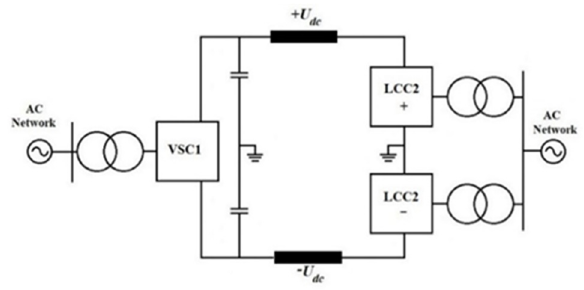
Figure 28. Hybrid bipolar HVDC transmission system.